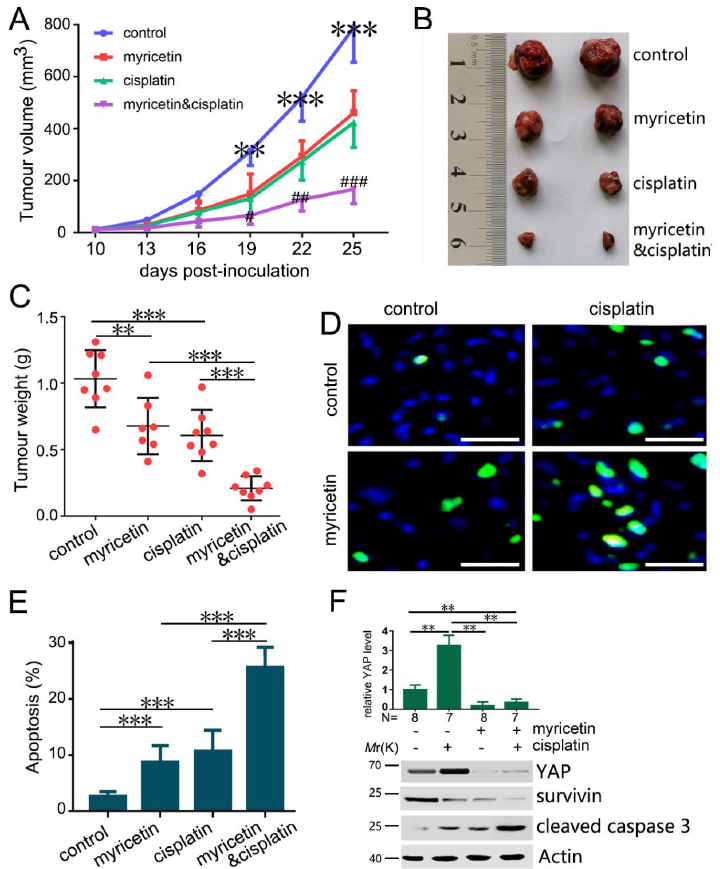
Figure 6. Myricetin sensitizes Huh-7 tumors to cisplatin in vivo. ( A ) Huh-7 cells were subcutaneously injected into BALB/C nude mice. The mice were treated with or without myricetin (30 mg/kg/day) and cisplatin (5 mg/kg/3 days). ( n = 8 for control; n = 7 for myricetin group; n = 8 for cisplatin group; n = 8 for combination treatment). The effect of myricetin and cisplatin on Huh-7 tumor volume is plotted. ** p < 0.01, *** p < 0.005, compared to medication groups. # p < 0.05, ## p < 0.01, ### p < 0.005, compared to myricetin or cisplatin alone treatment groups. ( B ) Representative images of tumors ( C ) The effect of myricetin and cisplatin on Huh-7 tumor weight is plotted. ** p < 0.01; *** p < 0.005. ( D ) TUNEL analysis of apoptosis in Huh-7 tumors treated with or without myricetin and cisplatin. Bar, 20 µm. ( E ) The apoptosis rate is plotted. *** p < 0.005. ( F ) The levels of YAP, survivin, and cleaved caspase 3 proteins in tumors treated with vehicle, myricetin, and cisplatin were analyzed by Western blot. The relative content of YAP after normalization to actin is shown. Values represent the mean ± SD. ** p < 0.005.